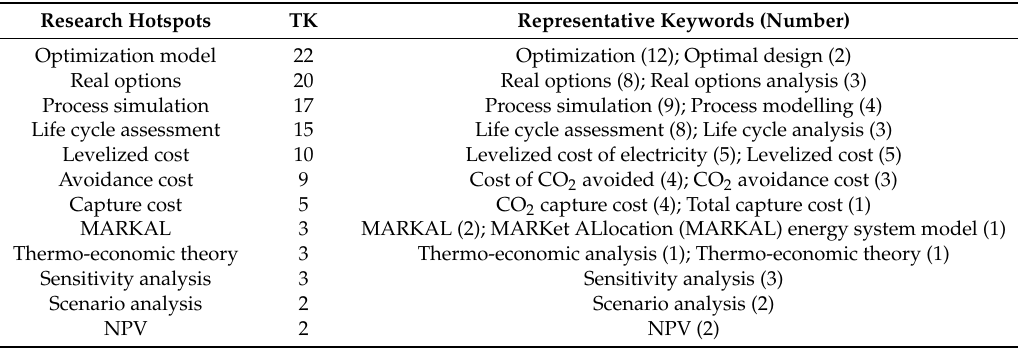
Table 10. Research methods and representative keywords. Research Hotspots Representative Keywords